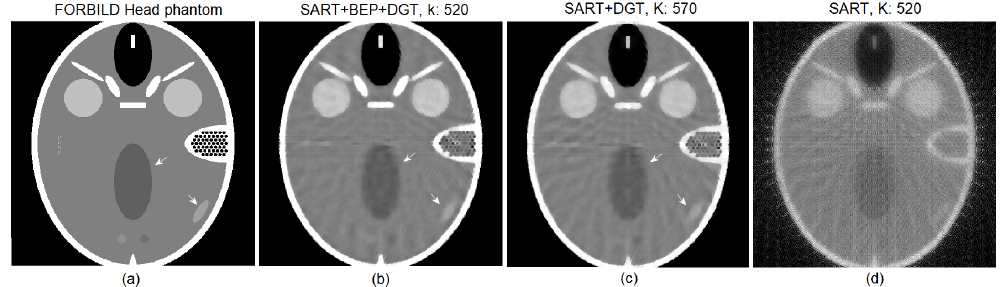
Figure 8. ( a ) The original FORBILD head phantom and particular reconstructions for 30 projections ( b ) from SART+BEP+DGT with k = 520 steps, PSNR: 70.7700, SSIM: 0.9015, ( c ) from SART+DGT with k = 570 steps, PSNR: 70.7706, SSIM: 0.8774, and ( d ) from pure SART with k = 520 steps, PSNR: 62.8476, SSIM: 0.1332. All with SNR = 46